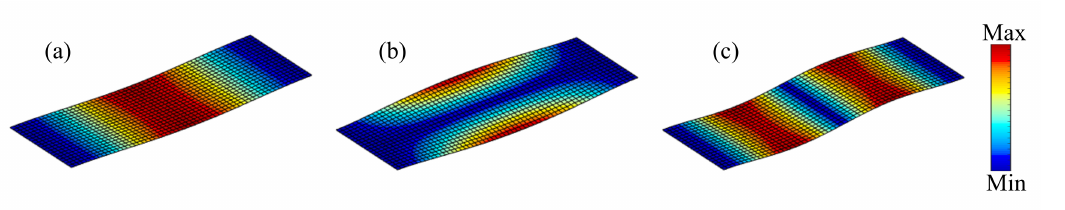
Figure 16. The first three eigenmodes of the plate clamped on two opposite edges. ( a ) The first eigenmode at 122 Hz. ( b ) The second eigenmode at 263 Hz. ( c ) The third eigenmode at 336